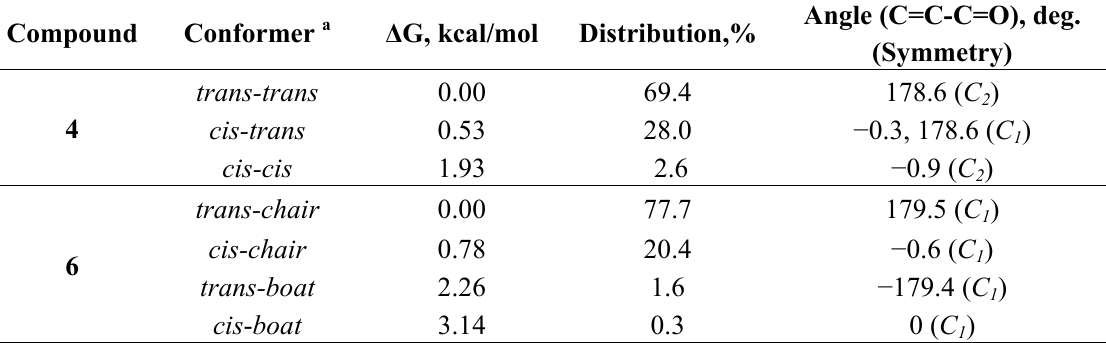
Table 1. Relative free energies, populations, symmetries, and torsion angles for low energy conformers of 4 and 6